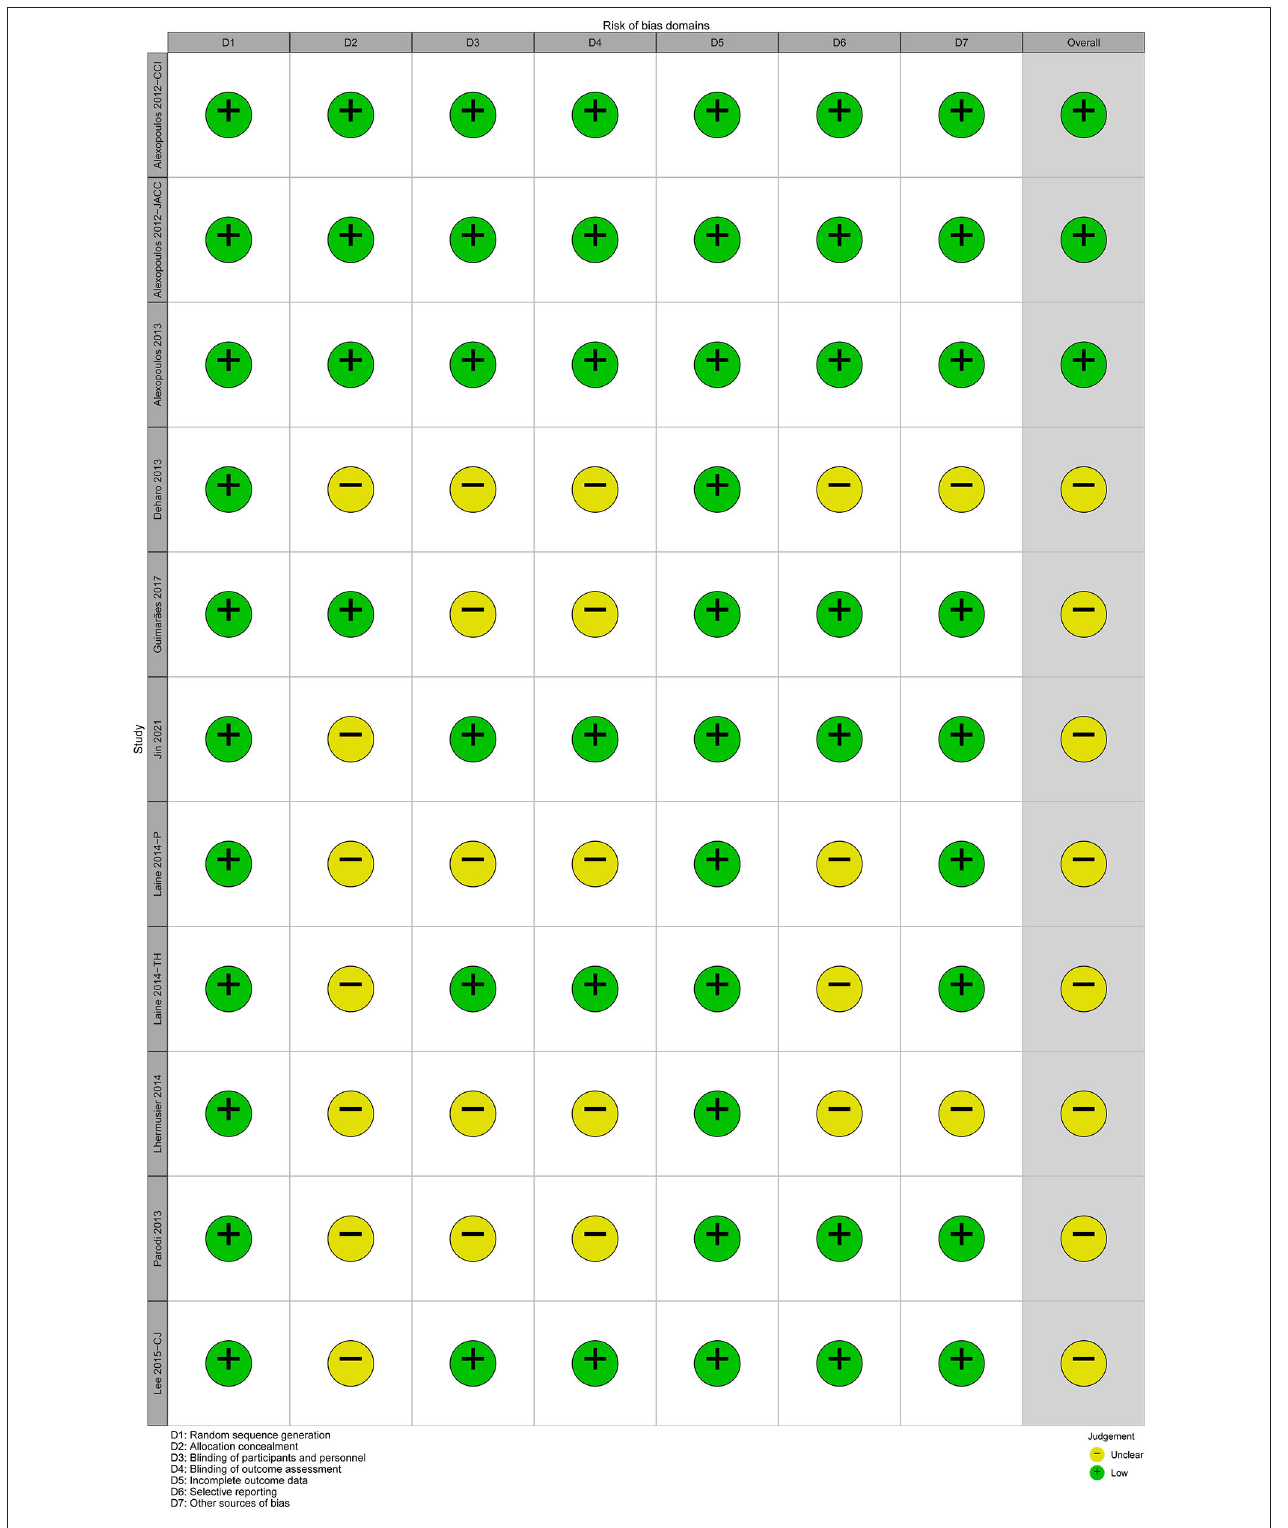
FIGURE 2 | Traffic light plot of risk of